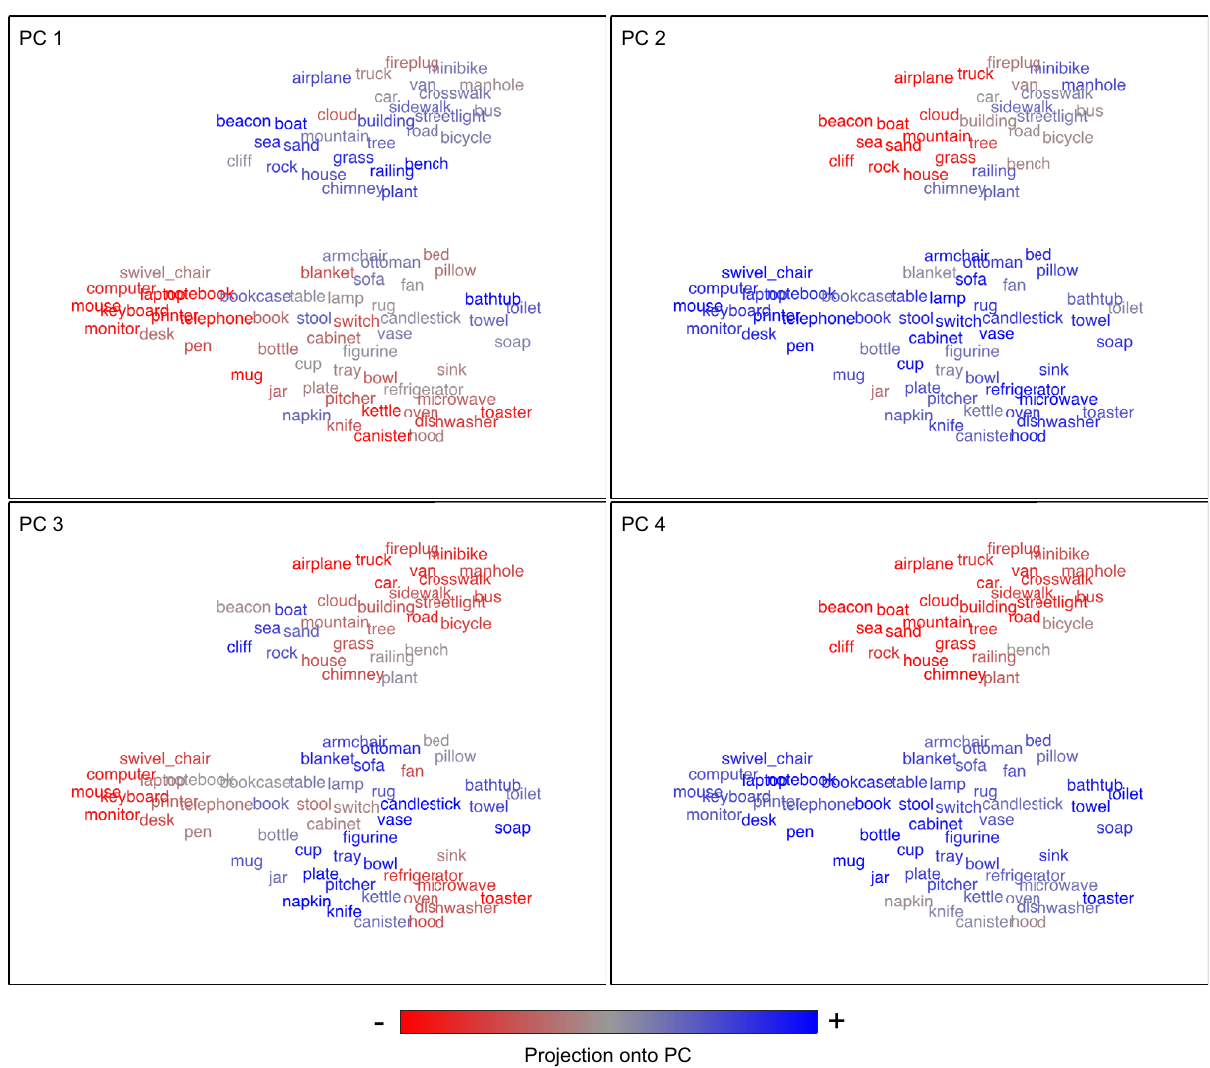
Fig. 10 Principal components of voxel tuning for visual object context. Principal components analysis was used to examine variance in encoding-model regression weights across voxels. This plot illustrates the fi rst four principal components (PCs) of the regression weights for the image-based object2vec encoding model, using all voxels with signi fi cant prediction accuracies. The 81 object categories from the fMRI experiment were projected onto each PC (as indicated by the color coding from blue to red). Thus, the PC score for each object is conveyed by color rather than spatial position. The spatial arrangement of the object categories is the same as in the tSNE plot of Fig. 1. We used this spatial arrangement to facilitate comparison with the embeddings before they were projected onto the encoding-model PCs and to facilitate comparisons of different PCs. At a coarse level, most PCs broadly distinguish between items found in indoor and outdoor environments. At a more fi ned-grained level, each PC organizes the objects into distinct sets of clusters, some of which appear to be semantically interpretable. For example, PC2 differentiates electronics and appliances from other indoor objects (e.g., microwave and computer vs. soap and napkin), and it also differentiates between man-made and natural items found in outdoor scenes (e.g., sea and sand vs. sidewalk and car). However, these PCs also contain complex clusters of objects that do not appear to have intuitive semantic interpretations. This semantic complexity may re fl ect the mixed selectivity that arises from encoding a large set of object contexts in a small number of representational dimensions (i.e., the 8 dimensions of object2vec). Source data are provided as a Source Data fi